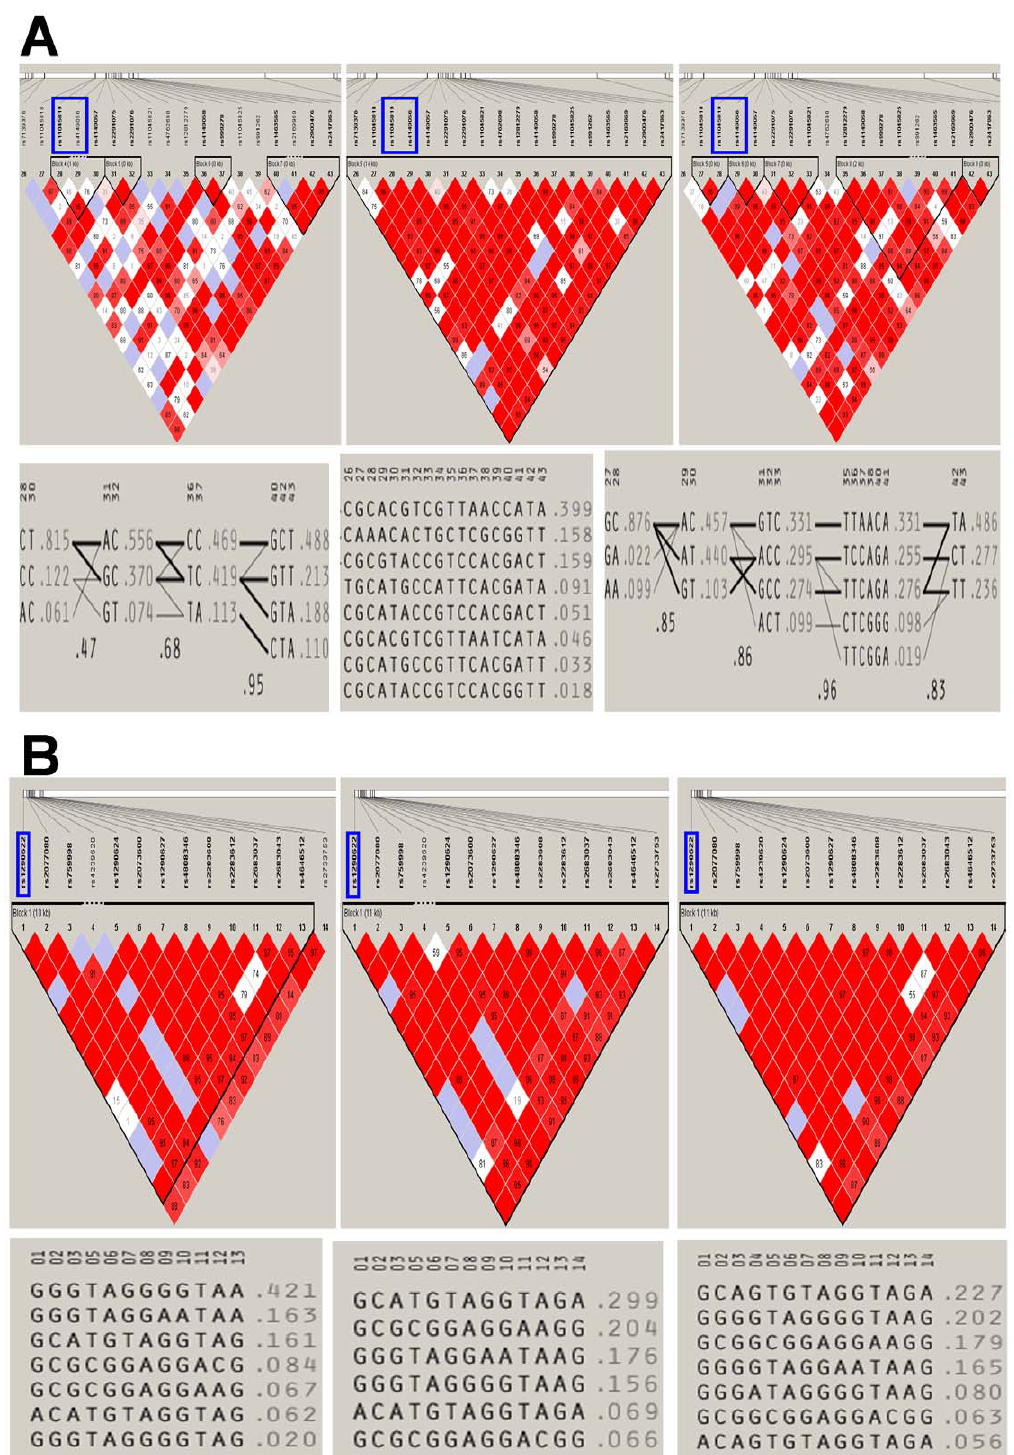
Figure 6. a: Linkage disequilibrium structure (Top) and organization of haplotypes harboring published pharmacogenomic variants (rsIDs indicated with blue boxes) in SLCO1B1 gene in biobank sample of African Americans (left column), European Americans (middle column), and Hispanic Americans (right column). b: Linkage disequilibrium structure (Top) and organization of haplotypes harboring published pharmacogenomic variants (rsIDs indicated with blue boxes) in CYP4F2 gene in biobank sample of African Americans (left column), European Americans (middle column), and Hispanic Americans (right column).